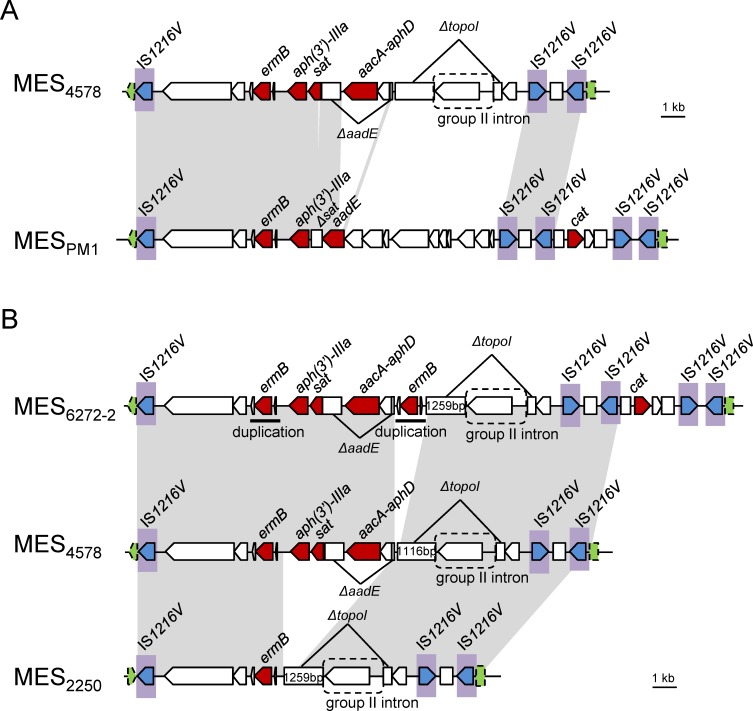
The comparison of MES structures integrated into the sasK gene.(A) MES4578 in ST59/SCCmec IVg MRSA strain 4578 is compared to MESPM1 in ST59/SCCmec V (5C2&5) MRSA strain PM1 (accession number AB699882) [23]. (B) MES6272-2, MES4578 and MES2250 in three ST59/SCCmec IVg MRSA strains 6272–2, 4578 and 2250, respectively, are compared. Homologous regions are shaded in gray. A Greek delta symbol indicates a truncated coding sequence. IS1216V with a transposase gene (tnp) is shaded in blue. The sasK gene is indicated in green arrow and box with dashed line.